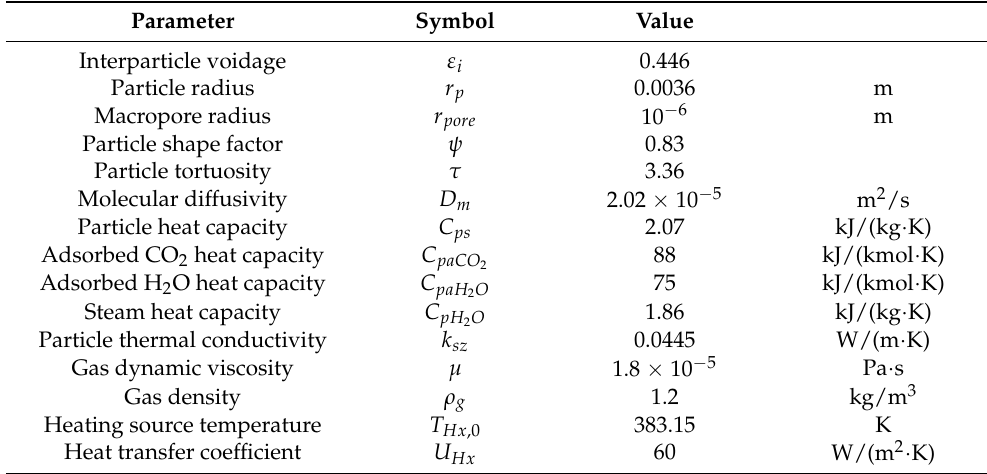
Table 2. Adsorbent properties and model